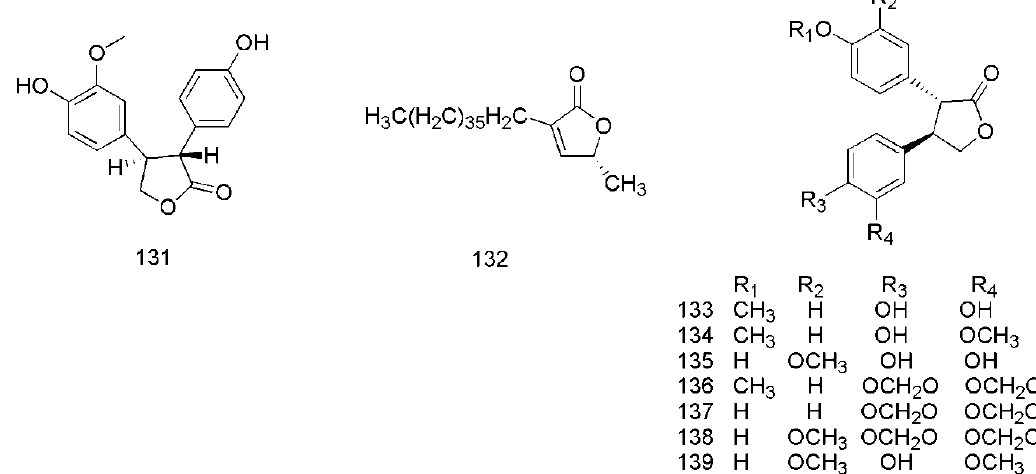
Figure 8. Chemical structures of the lactones in C. cassia .